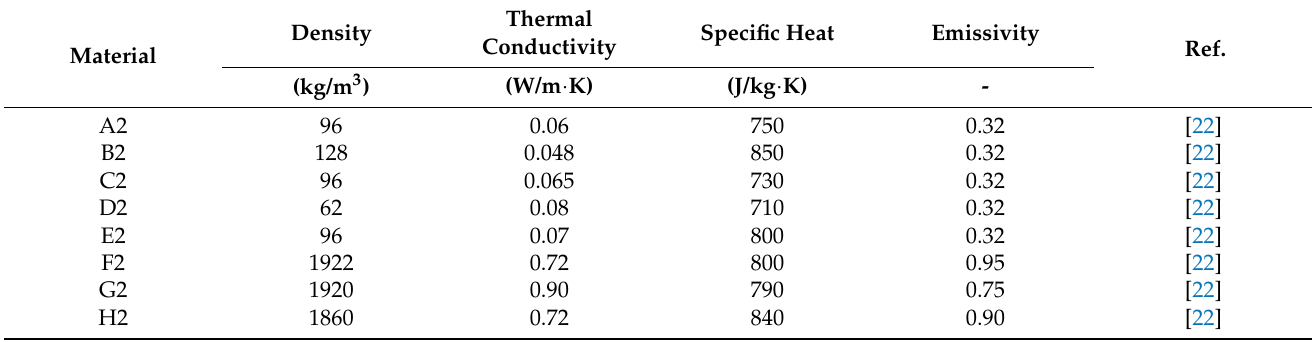
Table 3. Thermophysical properties of the selected insulating blankets and ceramic